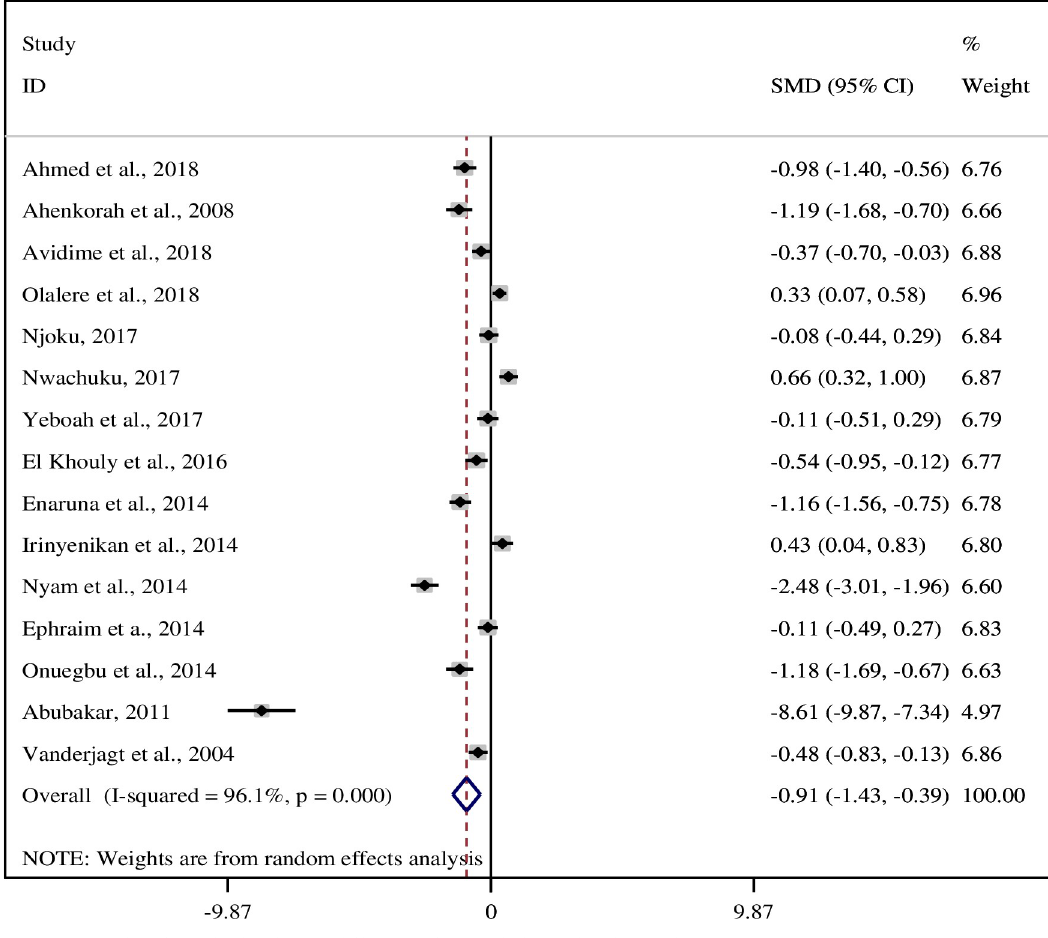
Fig 4. Forest plot of standardized mean difference of HDL-cholesterol and pre-eclampsia.